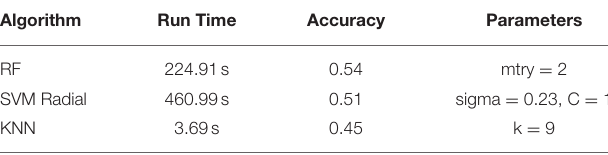
TABLE 3 | Run time, accuracy, and the final fit parameters for a random forest (RF), support vector machines with a radial kernel (SVM Radial), and k-nearest